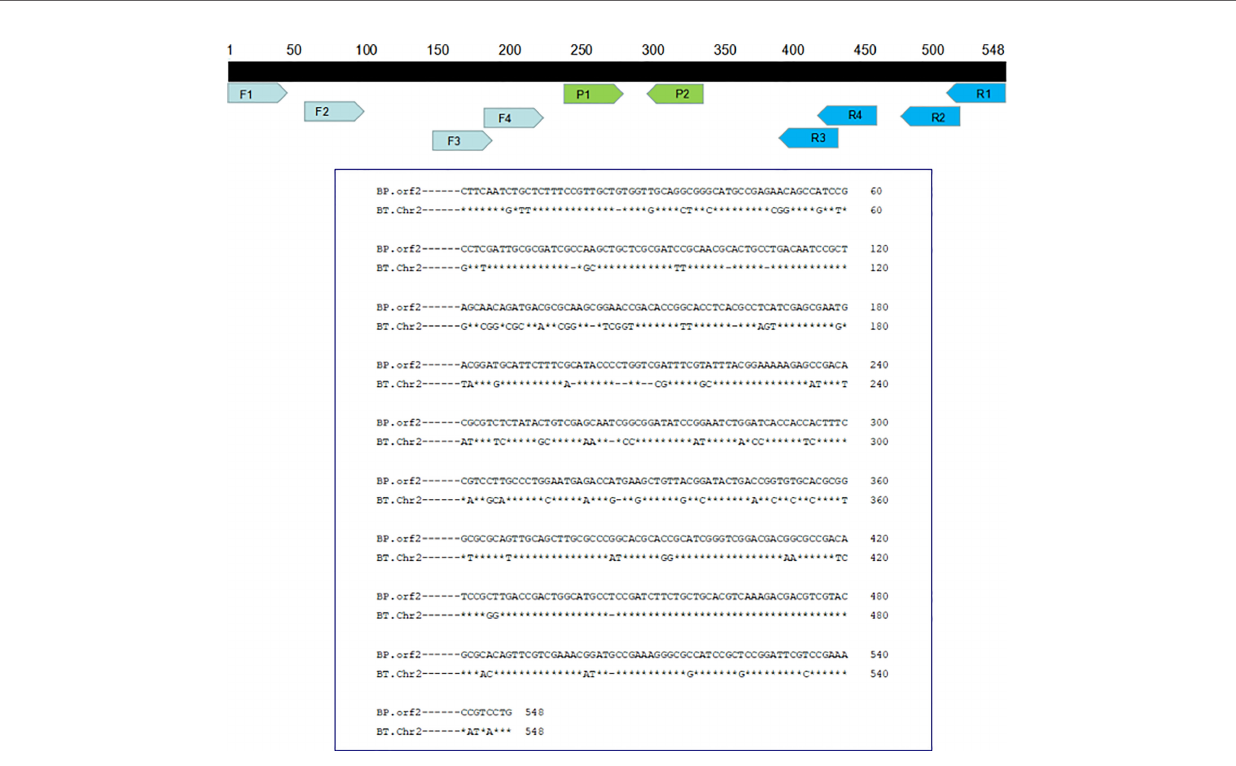
FIGURE 1 | Relative positions of the amplicon targets on the B. pseudomallei orf2 gene. The nucleotide sequence of B . pseudomallei -speci fi c target DNA is shown together with the locations of primers and probes and their names. B . pseudomallei : GenBank Accession No. AF074878; B . thailandensis : GenBank Accession No.